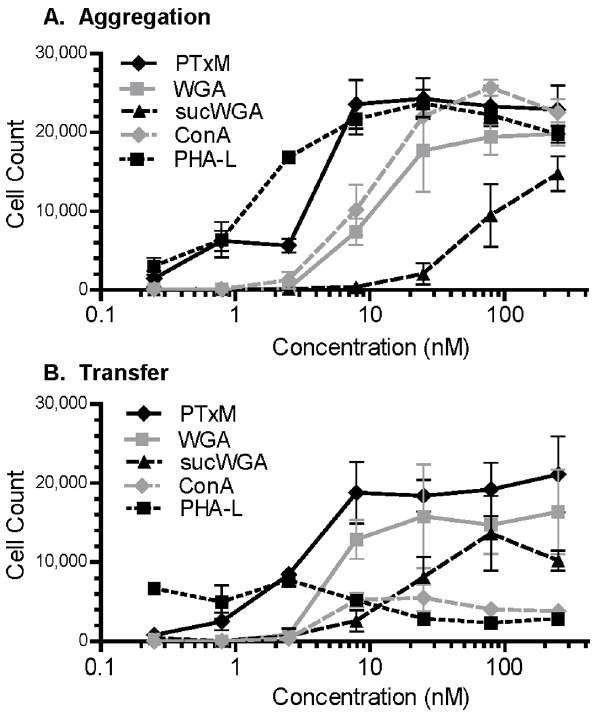
Figure 6. Effect of differing concentrations of lectin on Jurkat cell aggregation and membrane transfer population sizes. Results represent the mean of three independent assays with standard deviation. A. Jurkat cell aggregation. B. Jurkat cell membrane transfer.